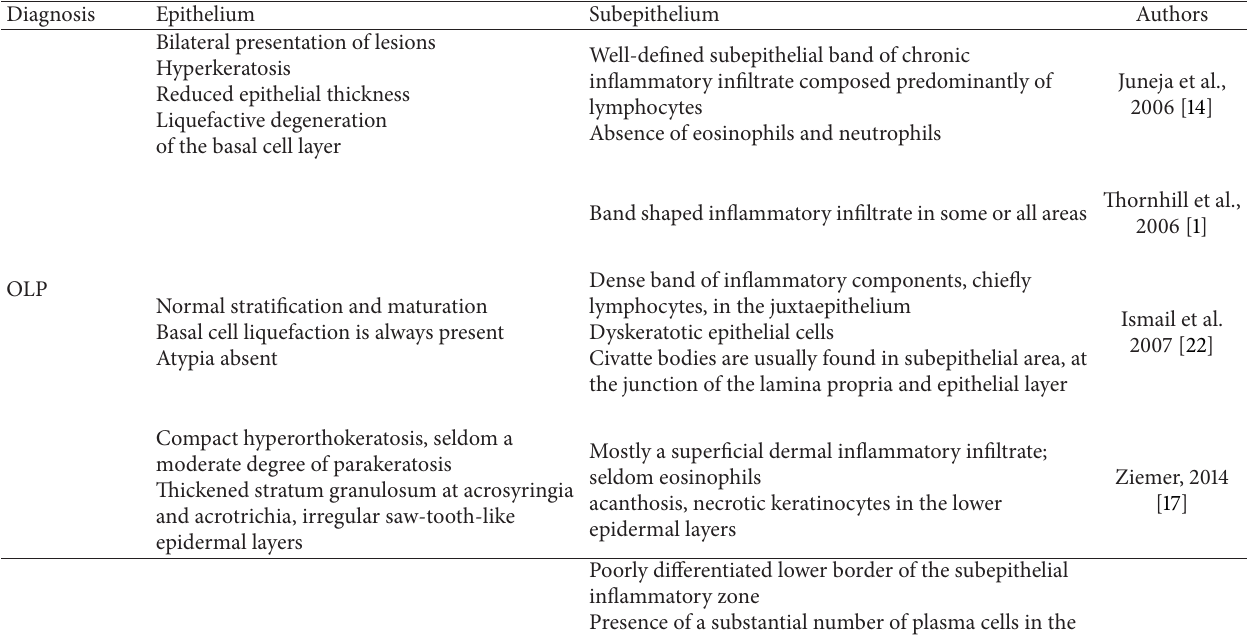
Table 1: Histopathological criteria distinctive of OLP and